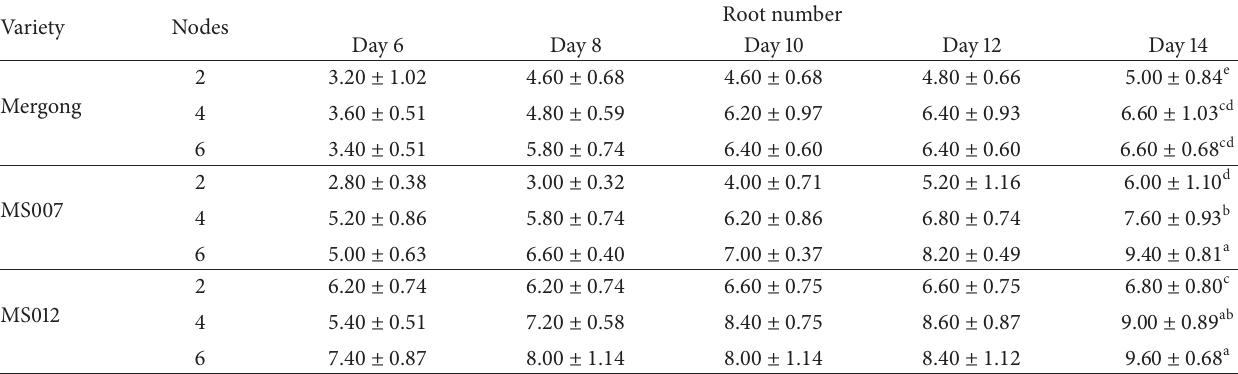
Table 1: Mean root number of three varieties having 2, 4, and 6 nodes cuttings from day 6 to day 14. Variety Nodes